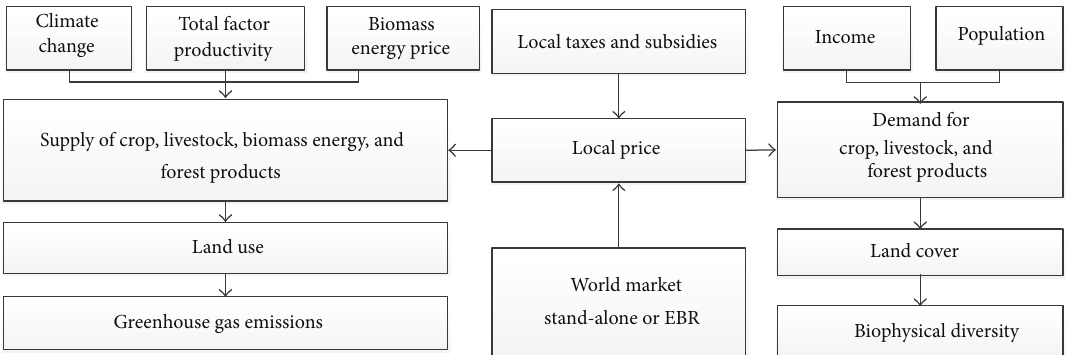
Figure 1: Land use allocation framework of